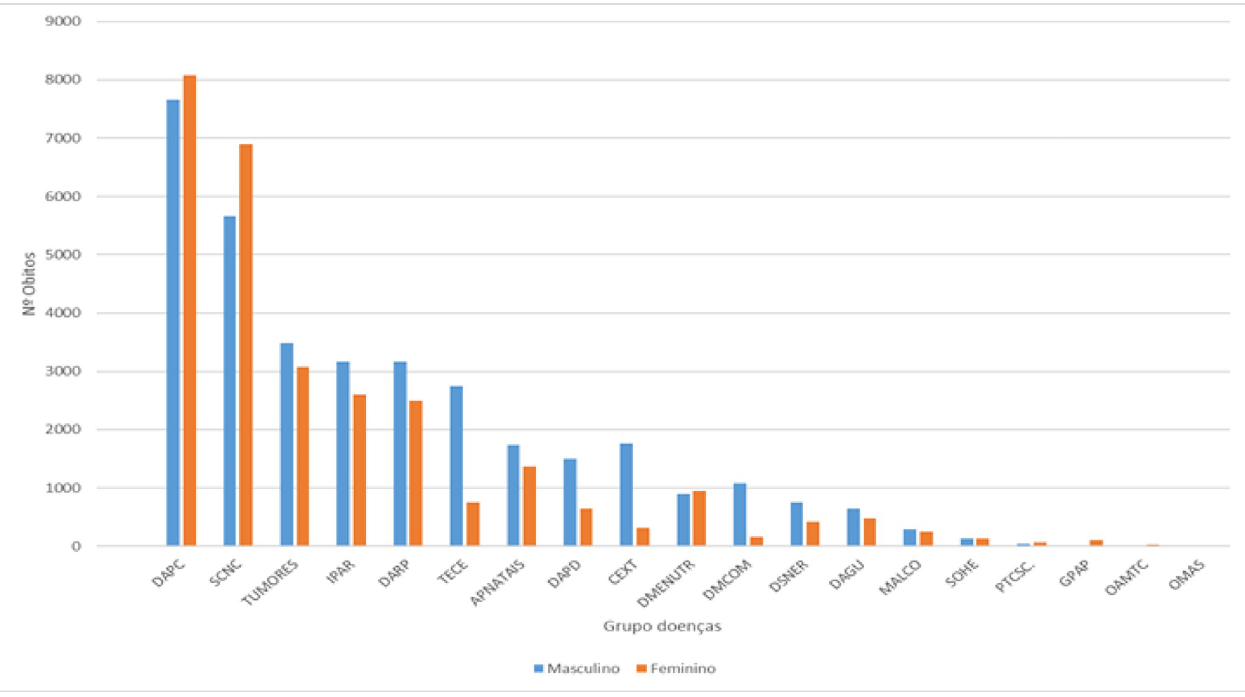
Fig 1. Distribution of deaths by sex and cause of death 1995 to